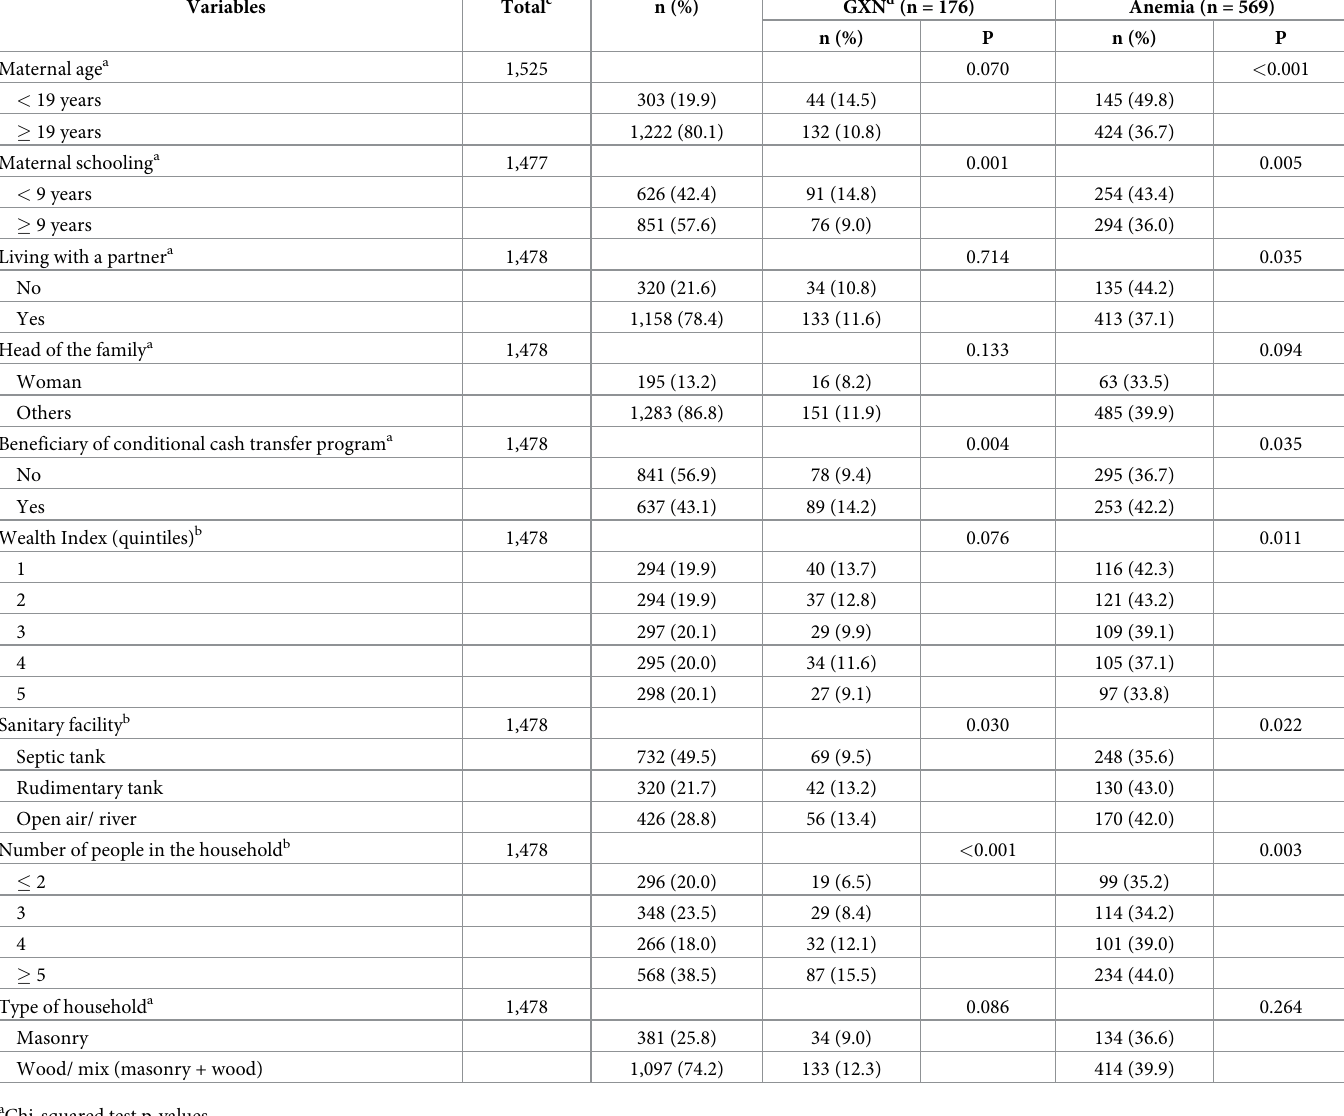
Table 1. Socio-demographic and environmental characteristics of parturients from the MINA-Brazil study by outcome.